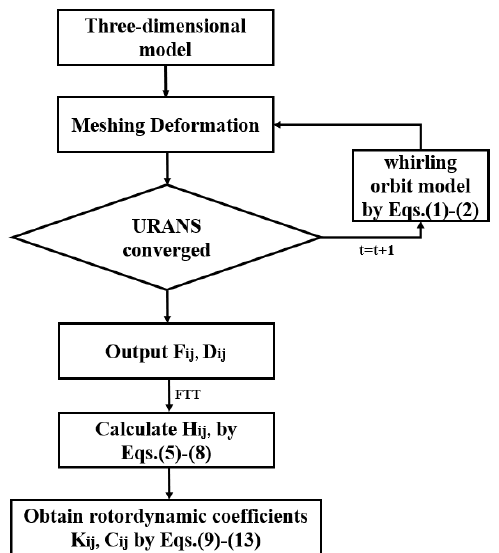
Figure 5. Computational methodologies for the seal rotordynamic coefficients.